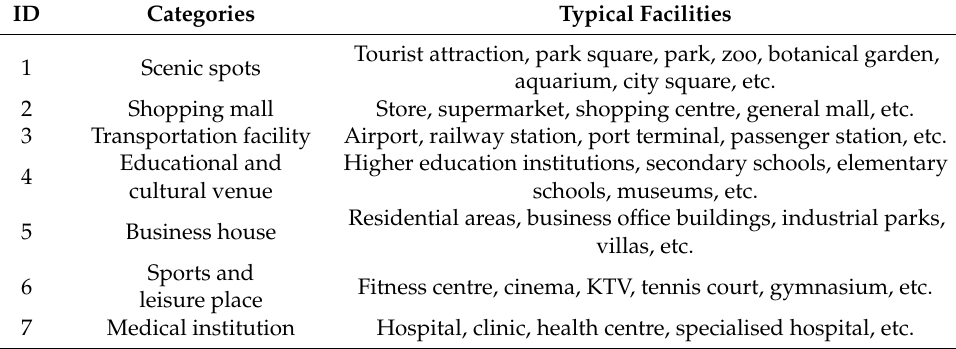
Table 1. Description of POI